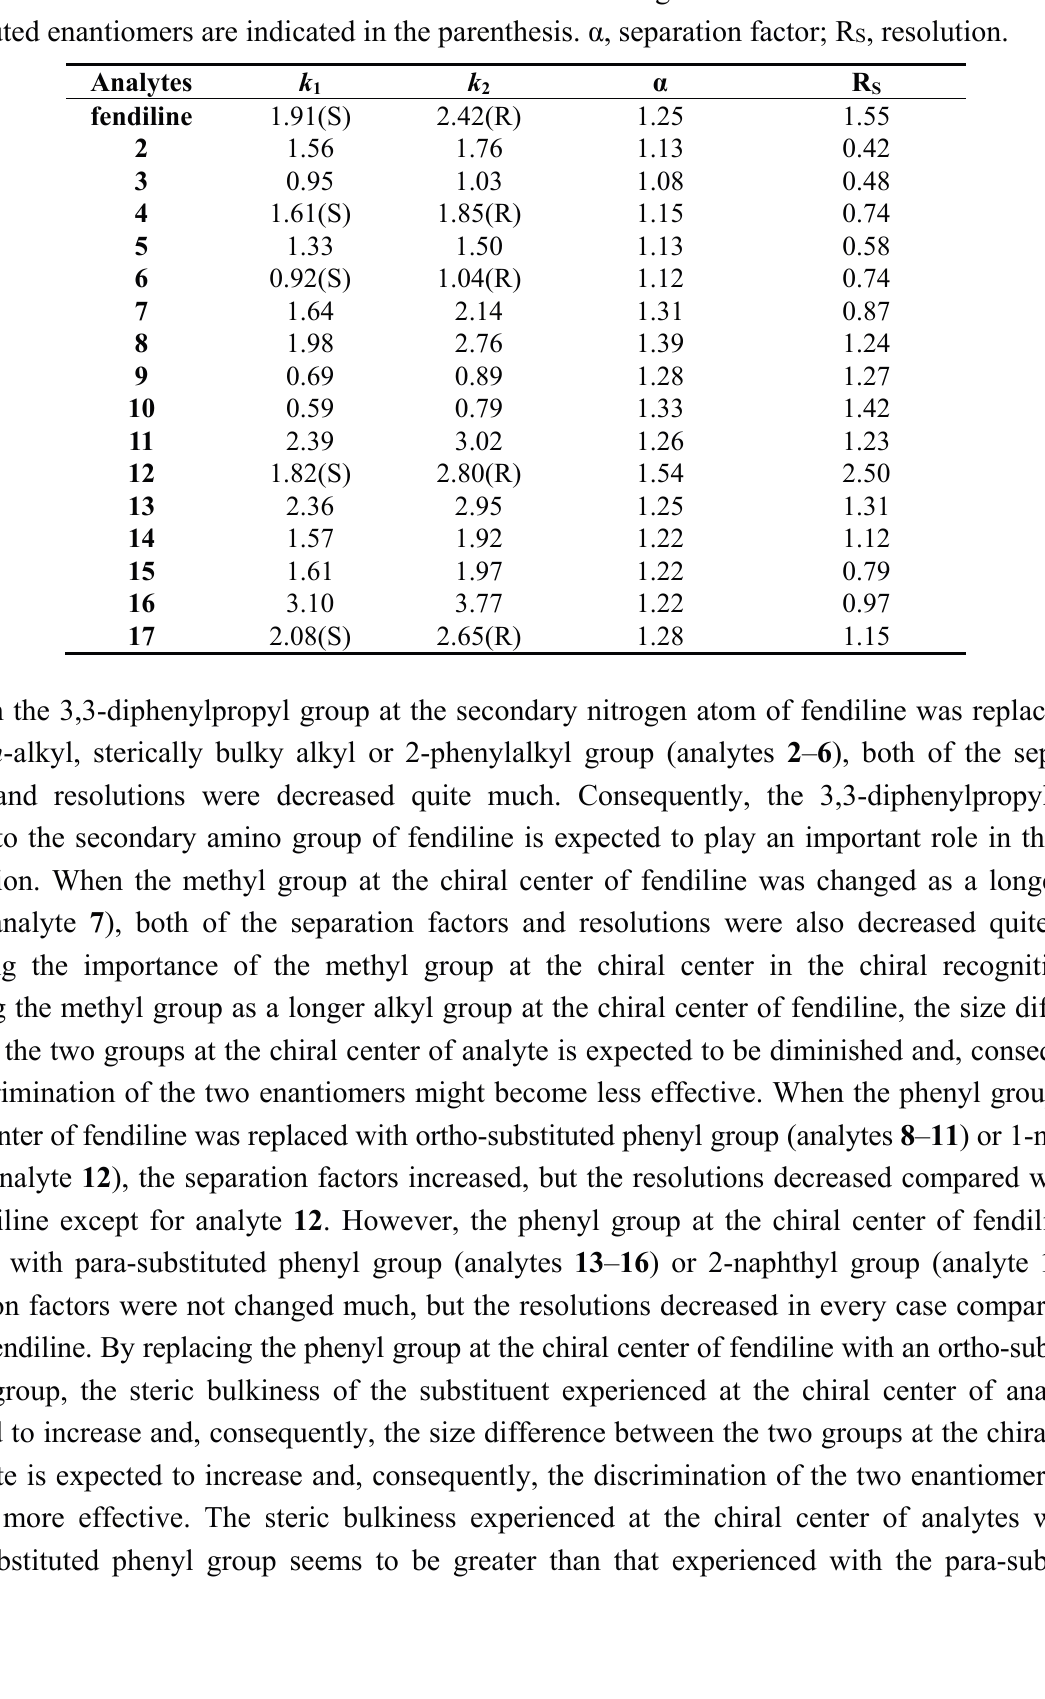
Table 3. Resolution of racemic fendiline and its analogues ( 2 – 17 ) on CSP 1 with the use of a mixture of methanol–acetonitrile–trifluoroacetic acid–triethylamine (MeOH–ACN–TFA– TEA, 80/20/0.1/0.5, v/v/v/v) as a mobile phase. Flow rate: 0.5 mL/min. Detection: 254